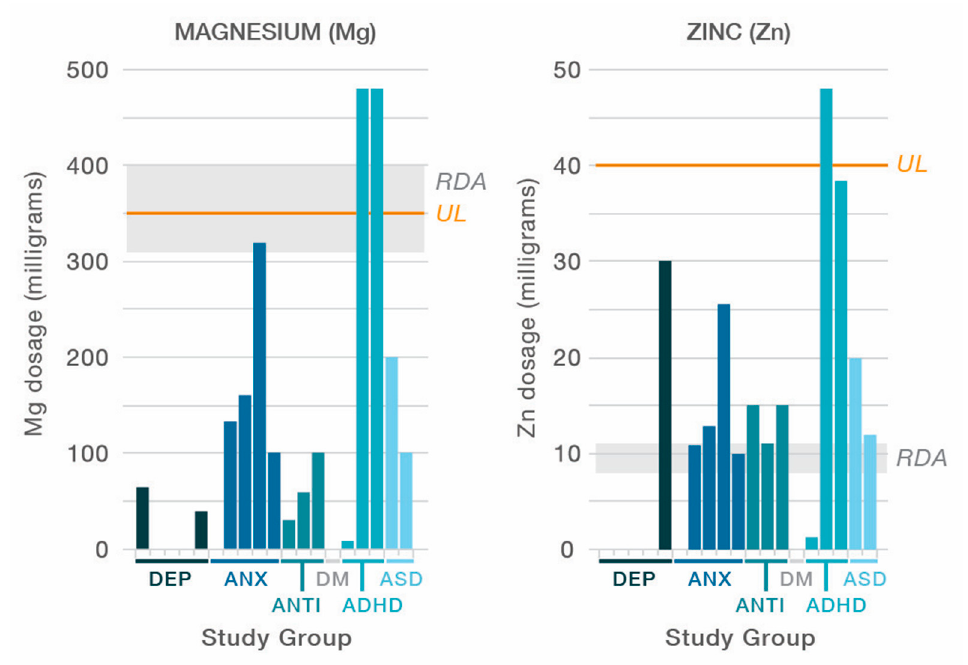
Figure 6. Comparing magnesium and zinc levels across studies. RDA = Recommended Dietary Allowance; UL = upper limit; DEP = depression; ANX = anxiety; ANTI = antisocial; DM = dementia behaviors; ADHD = attention-deficit/hyperactivity disorder; ASD = autism spectrum disorder.